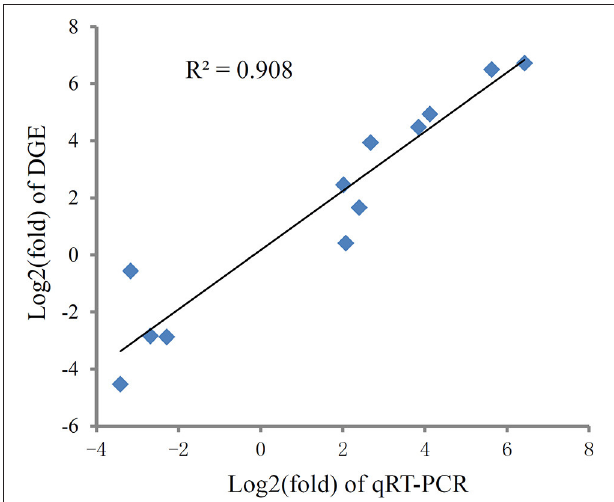
FIGURE 6 | Correlation of expression level analyzed by log2 RNA-Seq (y axis) with data obtained using log2 qRT-PCR, (x axis) from thermal and control group. The selected genes cover different expression levels of both up- and down-regulated